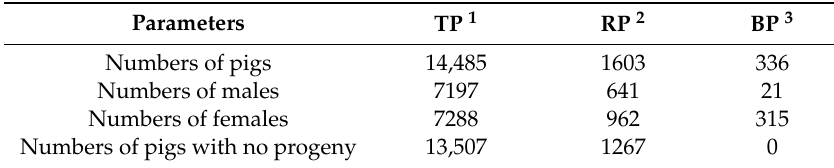
Table 1. Description of the data available in the entire pedigree dataset (TP), in the reference population (RP) and in the breeding population